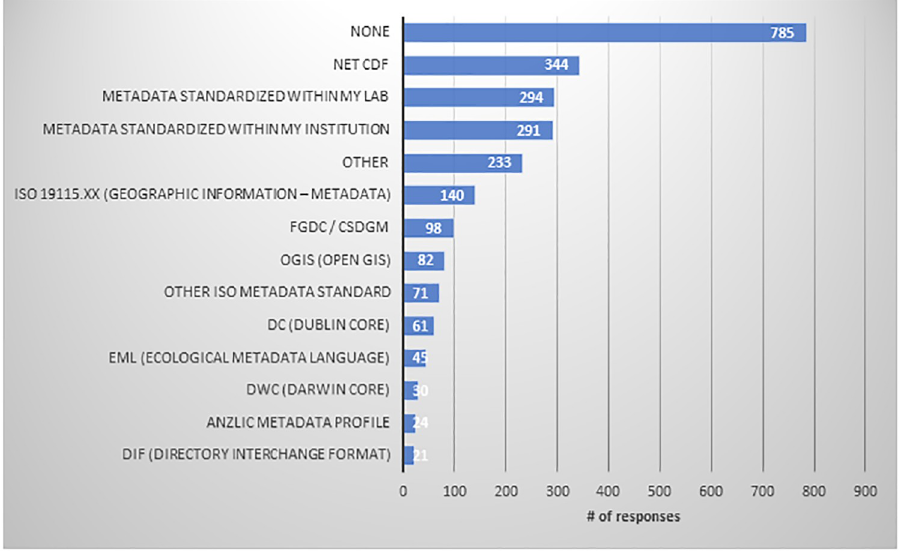
Fig 10. “What metadata standards do you currently use to describe your data, if any? (Choose all that